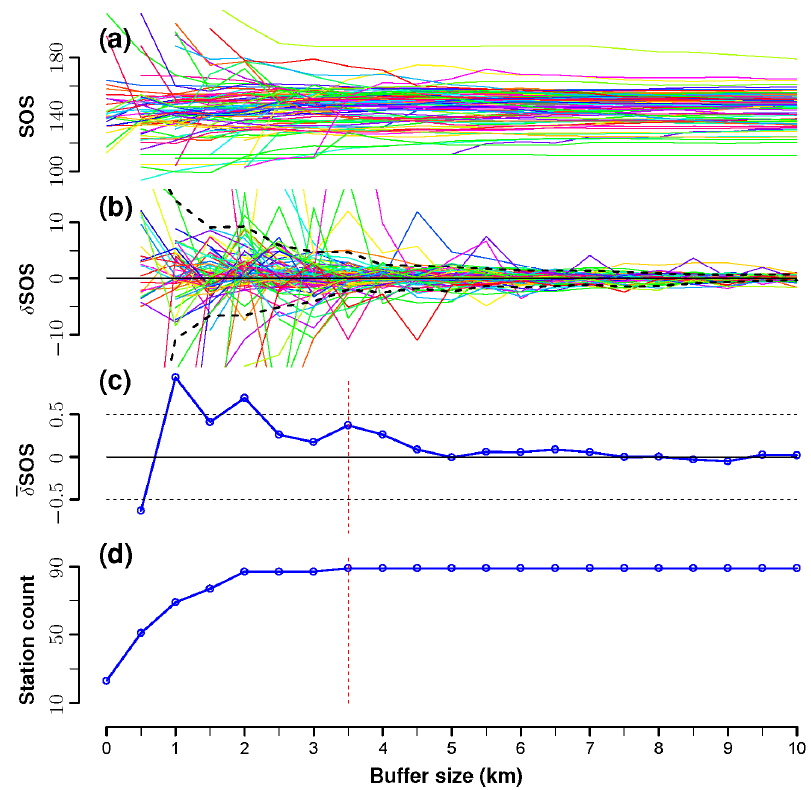
Figure 4. The optimal buffer size determination, taking MODIS-derived cropland SOS in 2005 as an example. ( a ) Station-specific SOS variations against the buffer size. Each station is represented by a distinct color; ( b ) SOS change ( δ SOS) at each buffer size increment; ( c ) average SOS change ( δ SOS) per buffer size increment; and ( d ) the count of valid stations. The vertical dotted line represents the obtained optimal buffer size.